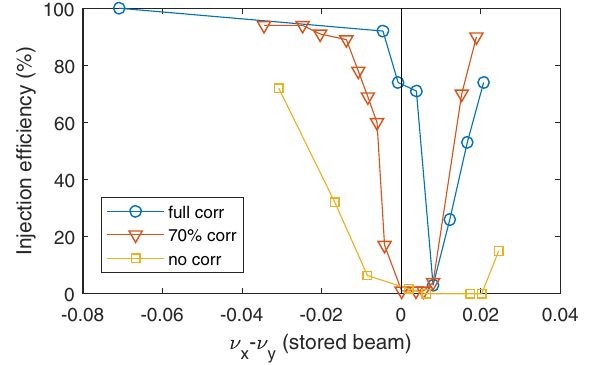
FIG. 2. Dynamic aperture measurements with full coupling correction.